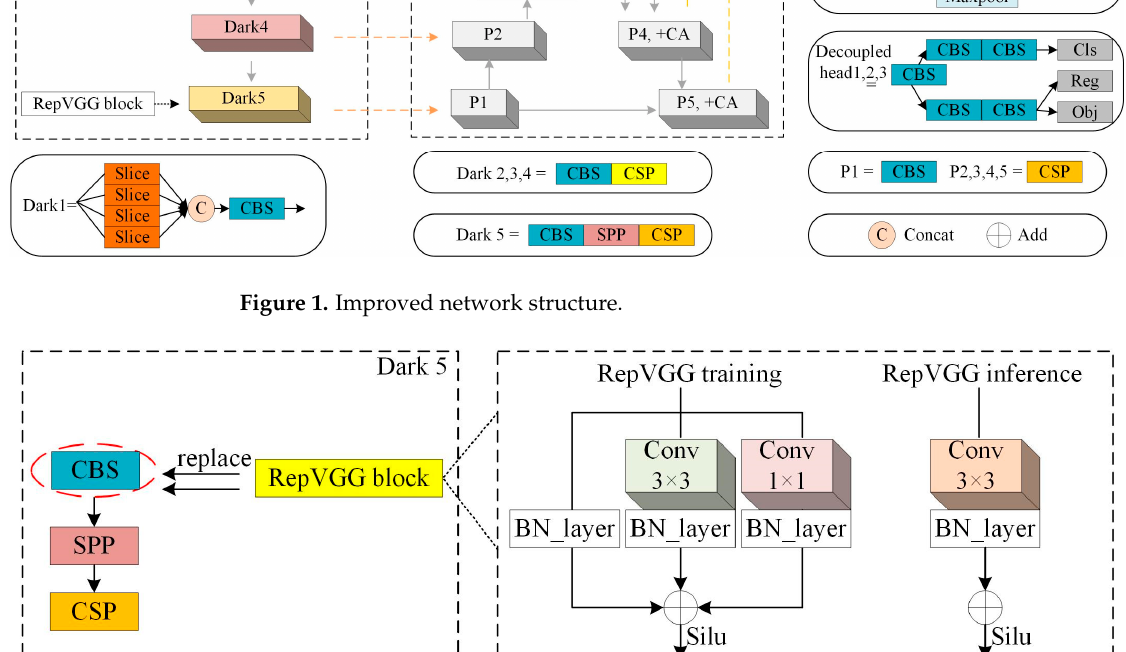
Figure 1. Improved network structure.